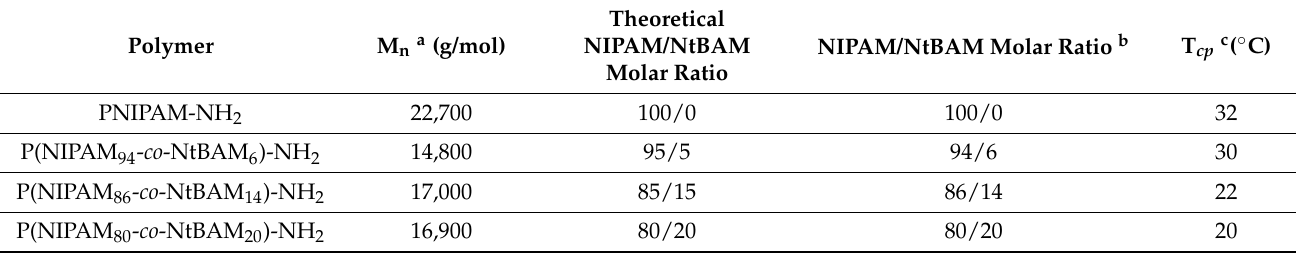
Table 1. Molecular characteristics of the grafting chains.